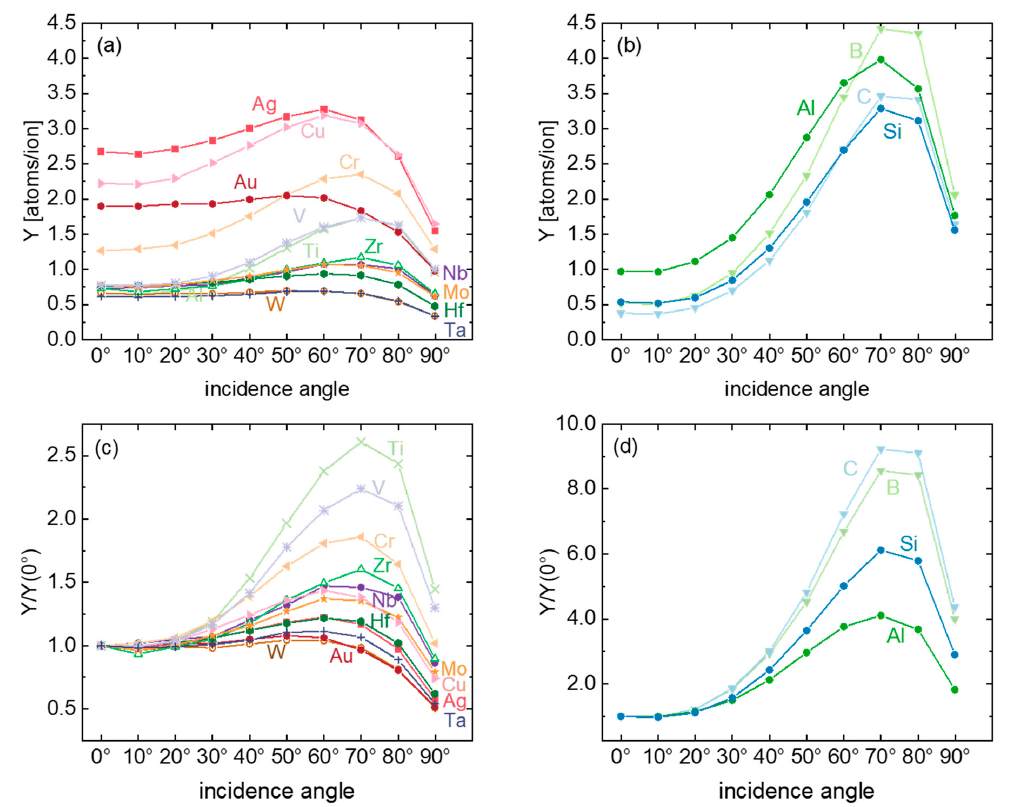
Figure 4. Total sputtering yield in dependence of ion incidence angle for ( a ) selected transition metals and ( b ) selected elements with Z ≤ 14. Normalized values against the normal ion impingement for the same elements are shown in graphs ( c , d ). Calculations were made by SRIM using Ar ions with 600 eV.